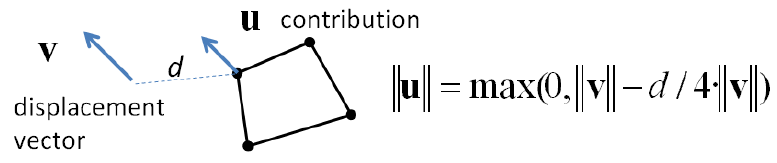
Figure 8. Conflation constraint 1: contribution of the displacement vector to the closest vertex of close features.